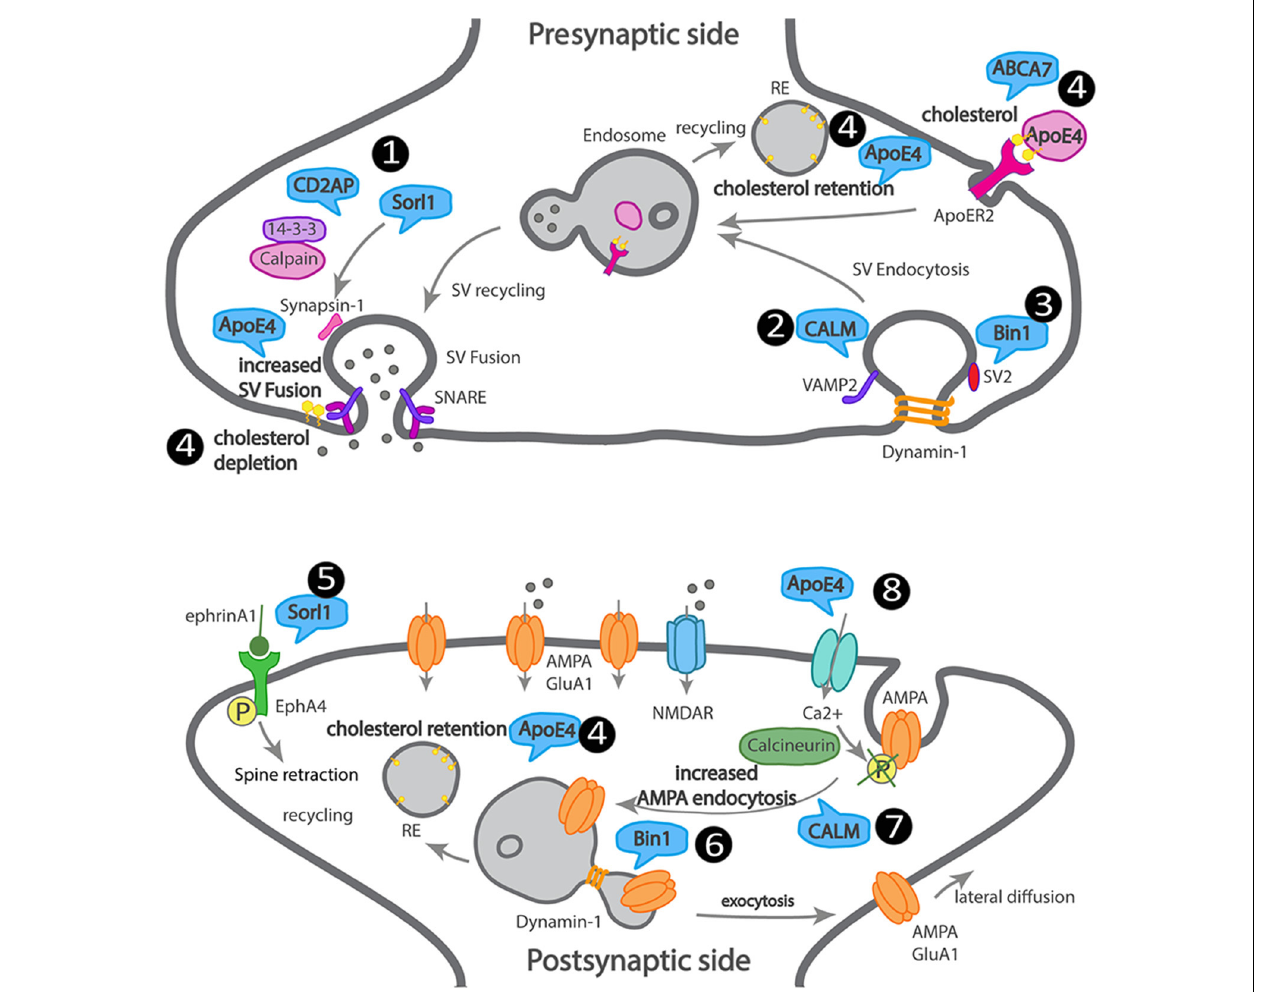
FIGURE 3 | Scheme of a dysfunctional LOAD synapse illustrating how LOAD trafficking genes impact synaptic trafficking. At the presynaptic terminal, 1. Sorl1 and Cindr (CD2AP homolog) interact with synapsin, via 14–3–3, and their loss of function leads to aberrant synapsin accumulation. 2. CALM mediates VAMP2 endocytosis and SNARE complex recycling. 3. Bin1 interacts with dynamin and SV2 and could play a role in SV endocytosis. 4. ApoE4 and ABCA7 alter the transport of cholesterol and other lipids into neurons, leading to cholesterol retention in recycling endosomes and depletion from the synaptic membranes. At the postsynaptic terminal, 5. Sorl1 attenuates EphA4 activation by ephrinA1, causing spine retraction. 6. Bin1 regulates GluA1 availability at synapses via recycling. 7. CALM regulates GluA2 availability at synapses via endocytosis. 8. ApoE4 regulates AMPA receptor availability at synapses via calcium influx, calcineurin activation, that dephosphorylates AMPA receptors triggering their